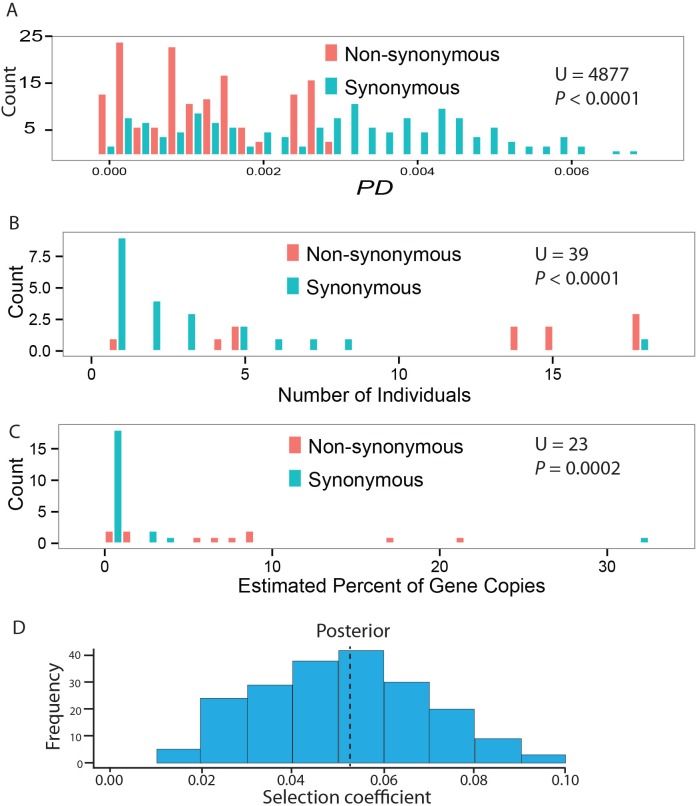
Selection on coding sequences.(A) Overall, there is higher diversity as measured by PD corrected for the number of sites in synonymous versus non-synonymous sites indicating purifying selection on the central Mup coding sequences as a whole. However, variation at a subset of non-synonymous sites appears to be under frequency-dependent selection. Consistent with frequency dependent selection, we find that (B) non-synonymous variants are found in more individuals and (C) occur at higher frequencies within individuals. (D) Simulations of the evolution of central Mup genes demonstrate that the patterns of variation observed here are inconsistent with neutral process and consistent with selection for distinctive phenotypes. The histogram shows the simulations that best fit the observed numbers and frequencies of non-synonymous and synonymous mutations. The fact that the best-fit simulations do not overlap zero argues for a role of selection in maintaining coding sequence diversity among the central Mup genes.